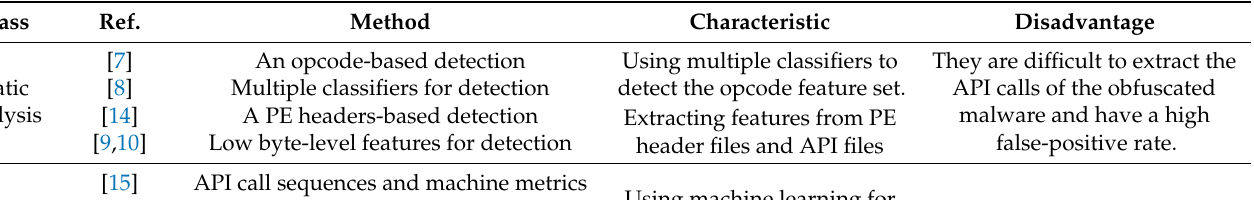
Table 1. Summary and comparison of existing